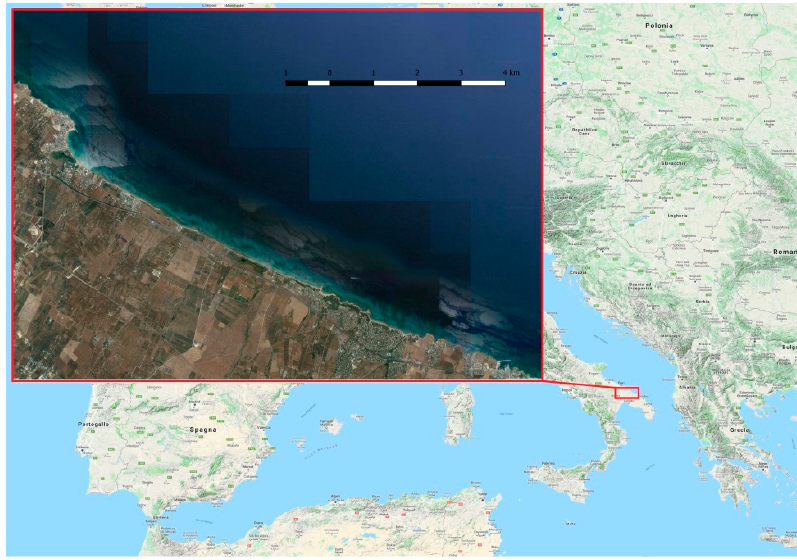
Figure 1. Case study area—Marinas of Torre Canne and Villanova, Apulia Region, Southern Italy.